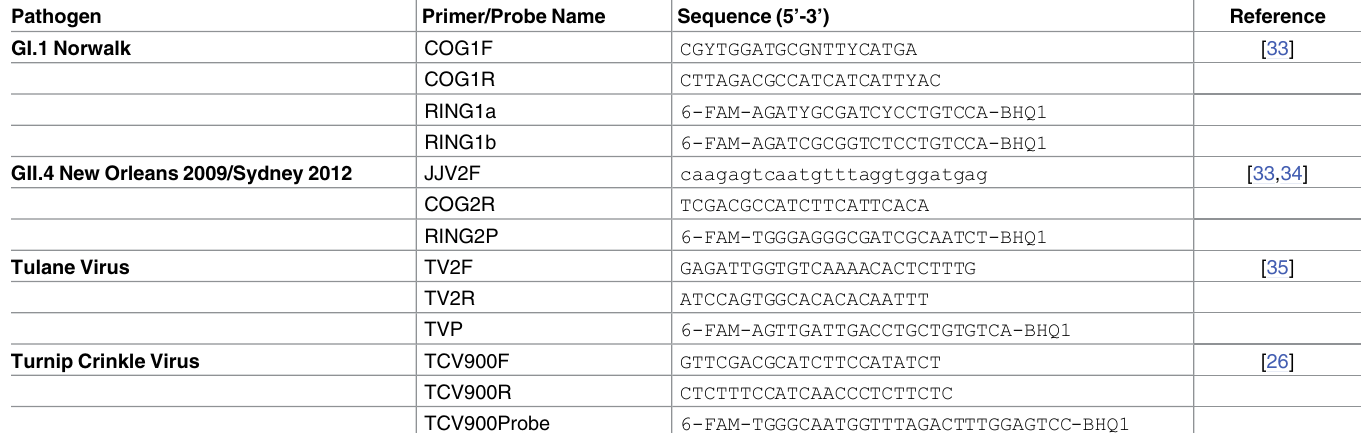
Table 2. Primers and probes used for RT-qPCR detection of viruses in this study.